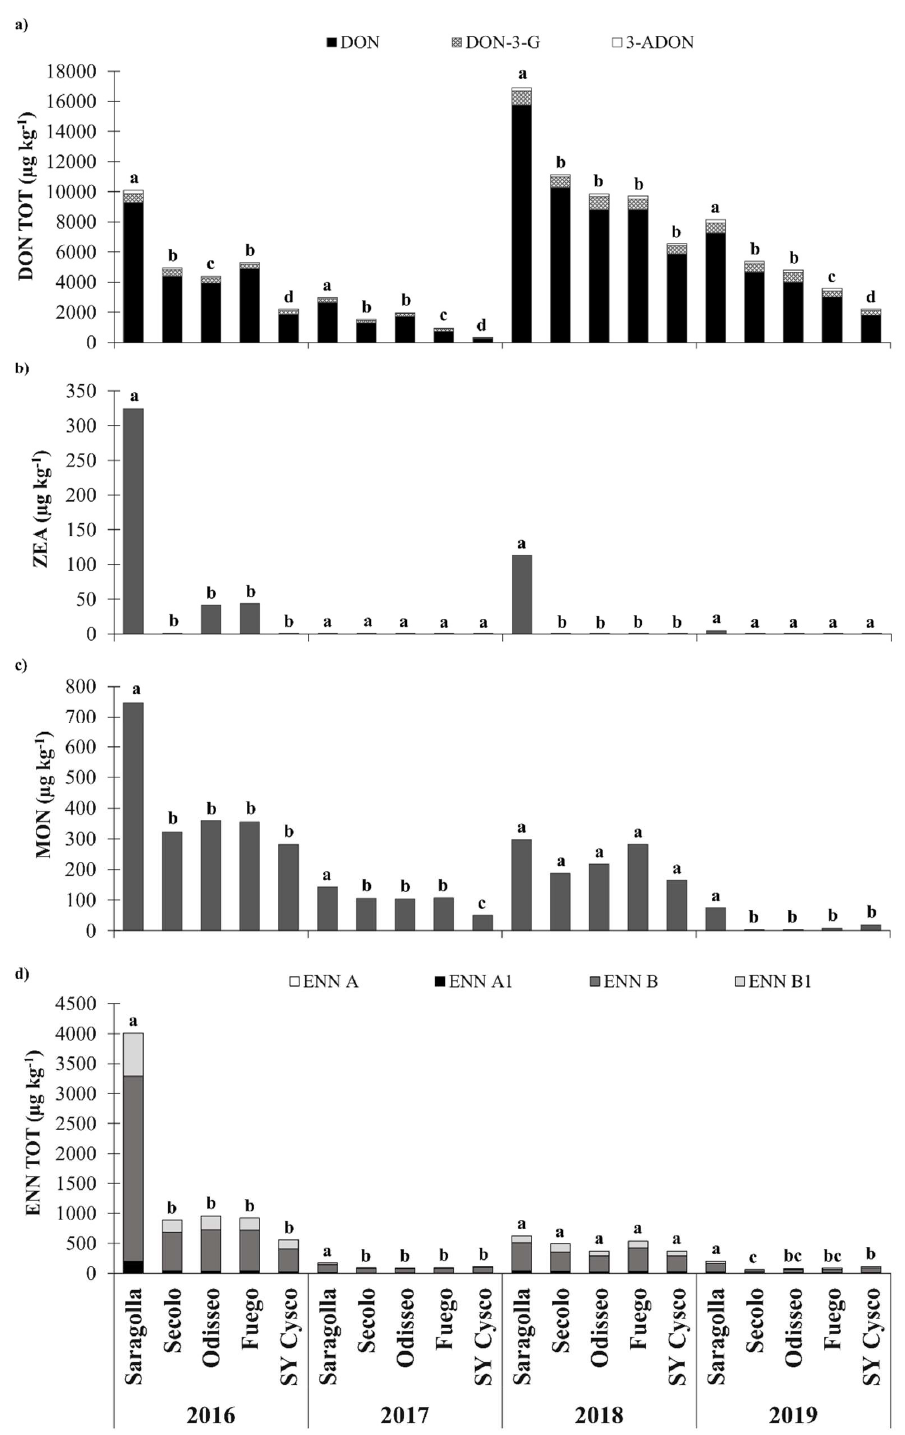
Figure 2. Effects of the growing season and durum wheat cultivar with different degrees of FHB susceptibility on the mycotoxin content in NW Italy during the 2015–2019 period: ( a ) Total deoxynivalenol content (DON TOT = sum of deoxynivalenol, DON; deoxynivalenol-3-glucoside, DON-3-G; and 3-acetyldeoxynivalenol, 3-ADON); ( b ) Zearalenone (ZEA) content; ( c ) Moniliformin (MON) content; ( d ) Total enniatin content (ENN TOT = sum of enniatin A, ENN A; enniatin A 1 , ENN A 1 ; enniatin B, ENN B; and enniatin B 1 , ENN B 1 ). Different letters above the bars indicate significant differences between cultivars for each growing season ( p < 0.05). The reported data are the average of 3